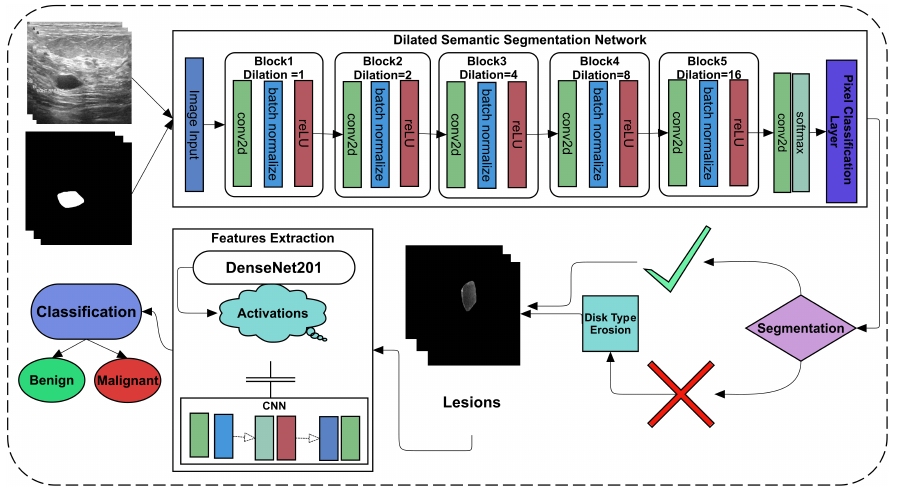
Figure 1. Flowchart of proposed framework.